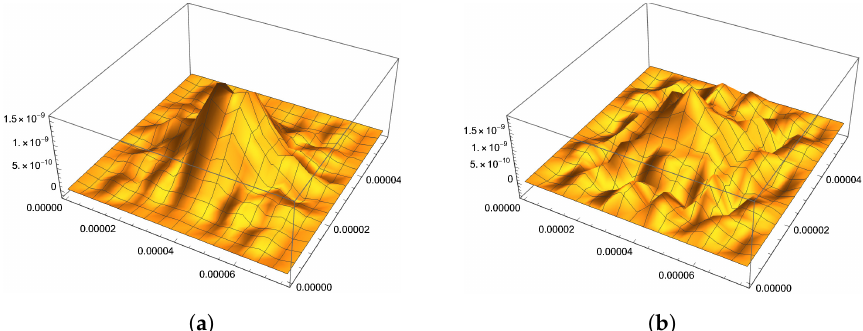
˜ Ω =] x c − L X /8, x c + L X /8 [ × ] y c −